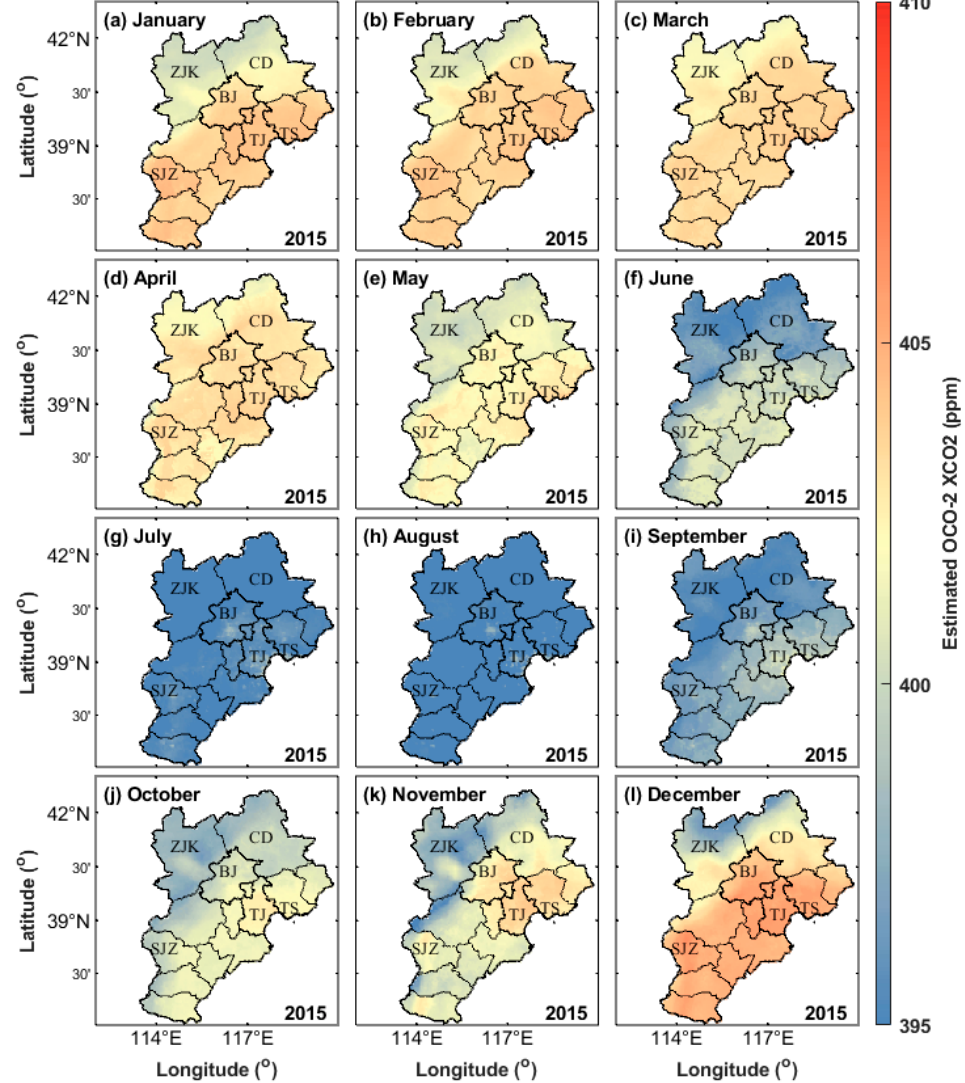
Figure 10. Monthly average XCO 2 concentrations in the Beijing–Tianjin–Hebei region from January 2015 to December 2015. ZJK, CD, BJ, TJ, TS, and SJZ represent Zhangjiakou, Chengde, Beijing, Tianjin, Tangshan, and Shijiazhuang, respectively. ( a – l ) represent January to December respectively. Figures 10 and 11 show that the XCO 2 concentration in the Beijing–Tianjin–Hebei region shows fluctuations. Simultaneously, it has a rhythm: the XCO 2 concentration is higher in spring and winter, followed by autumn, and the lowest in summer, which has a rhythm of seasonal